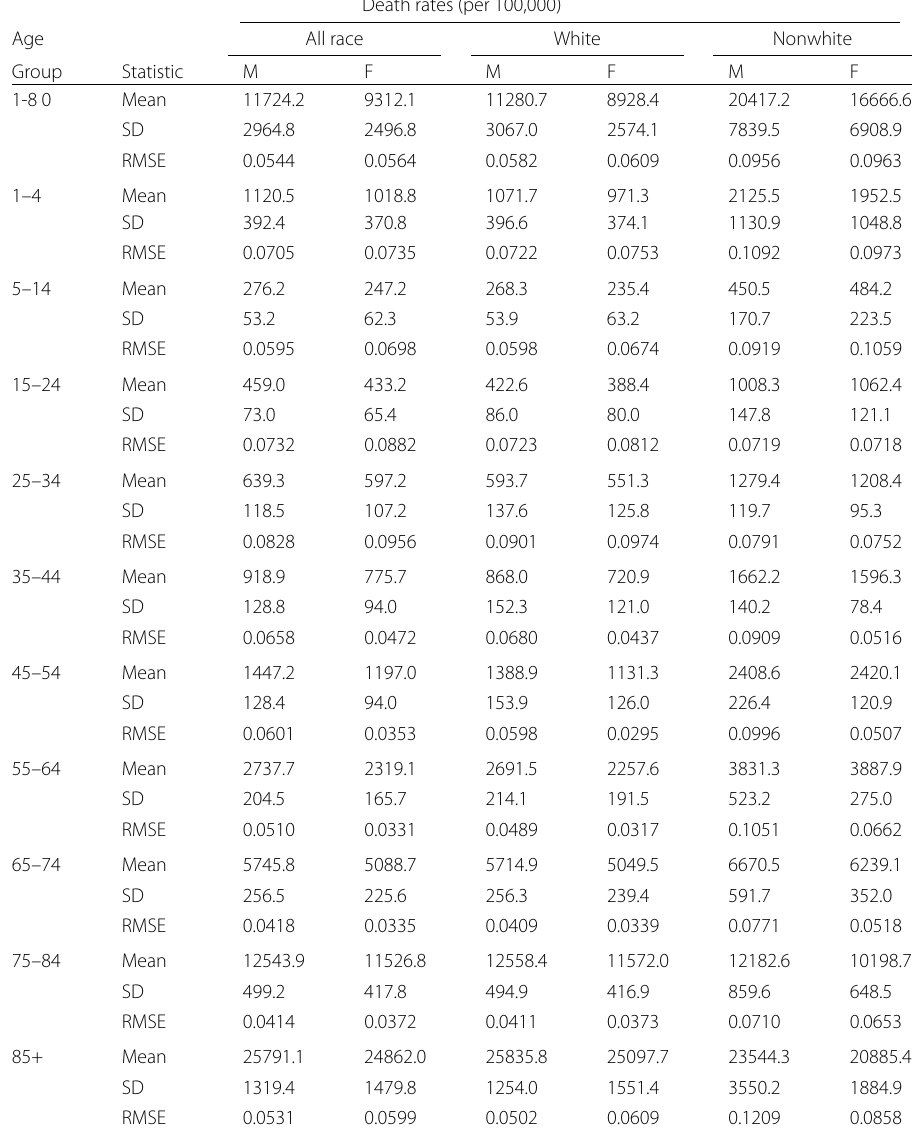
Table 3 For the all-years